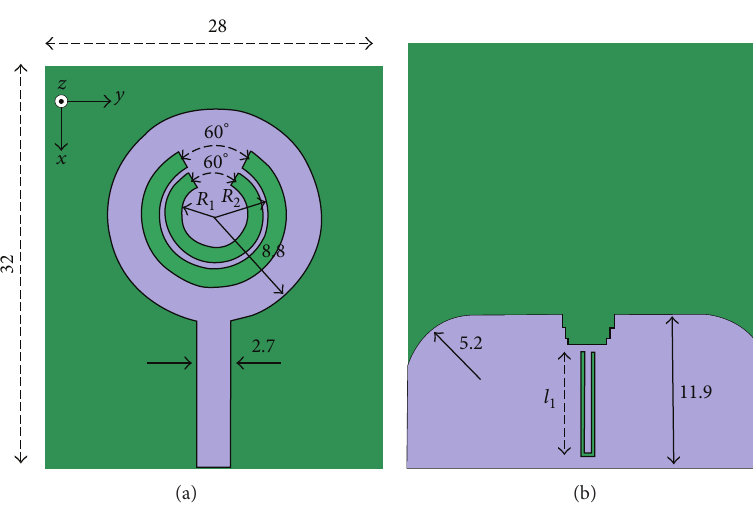
Figure 1: Geometry of the proposed antenna. (a) Top view, (b) bottom view (unit: millimeters).